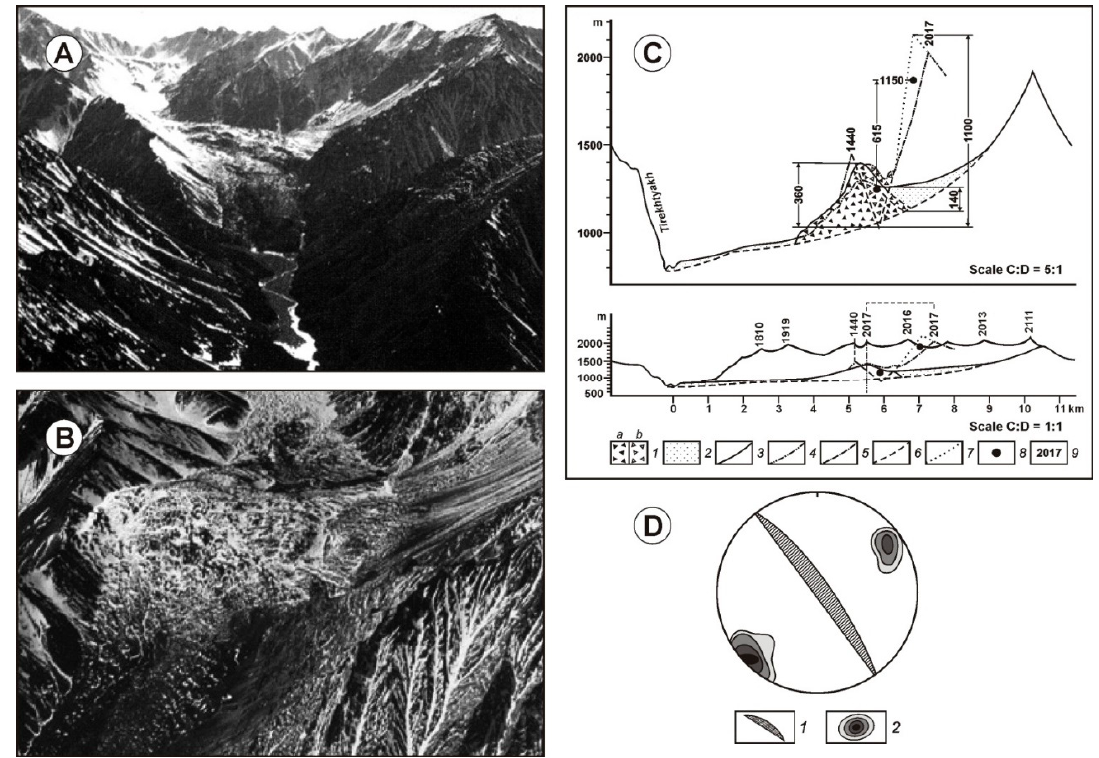
Figure 8. Dam on the Eryun–Tas–Takh River (after [25,26]). ( A ) front view (the headwater segment the Eryun–Tas–Takh River is blocked by the dam); ( B ) top view (the river valley and the detachment wall are blocked by collapsed rocks); ( C ) transverse profile across the seismogenic dam (after [28]):